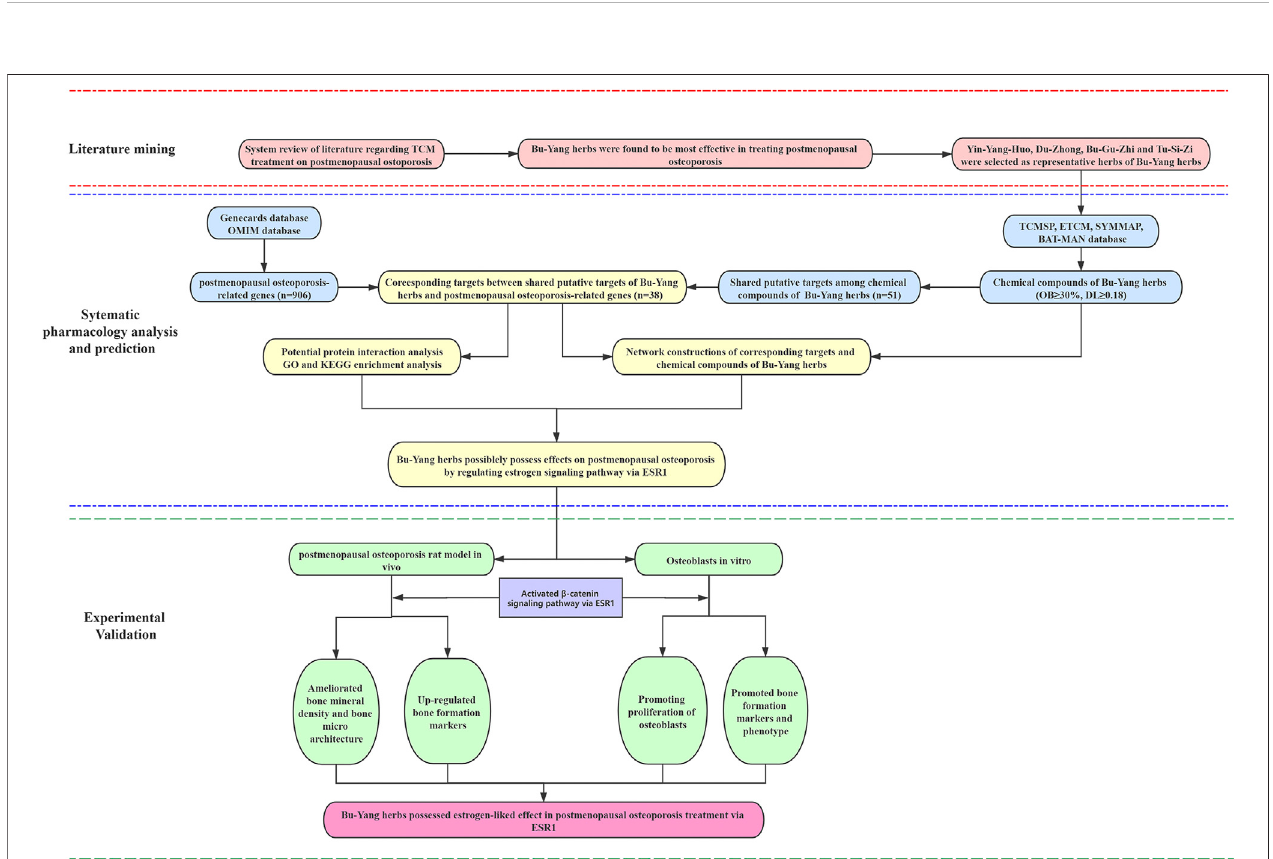
FIGURE 1 | A combined strategy of literature mining, systematic pharmacology, and experimental validation in investing TCM treatment on PMOP.